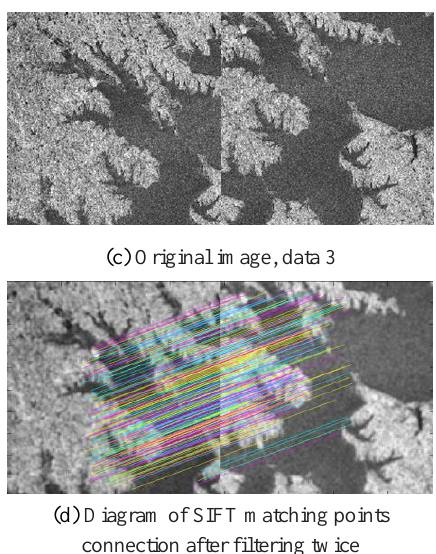
Figure 3. Original image and the matching result of SIFT algorithm to the enhanced image